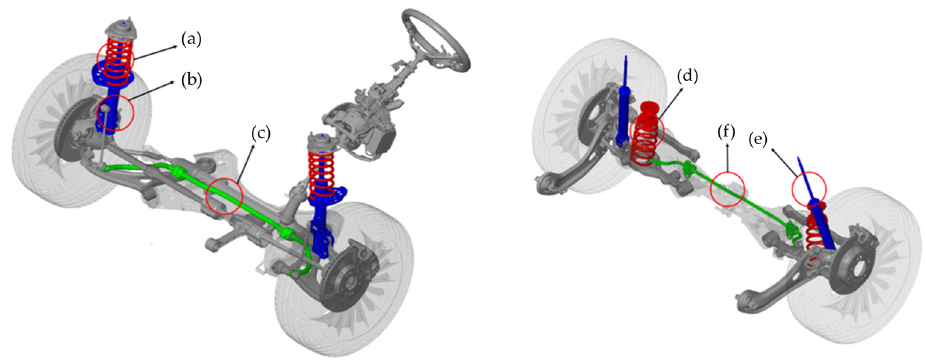
Figure 1. Target vehicle.